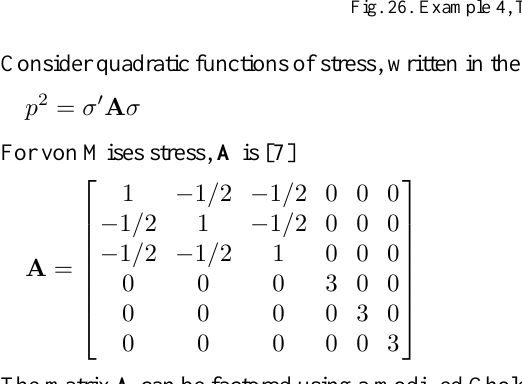
Fig. 26. Example 4, Time histories of the